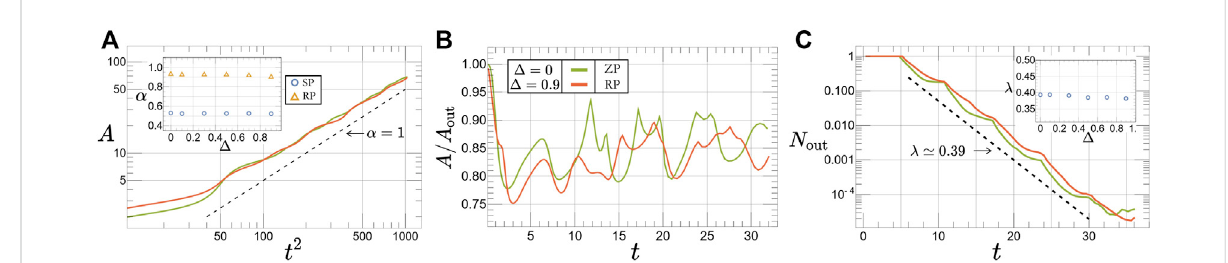
FIGURE 6 Long-time properties of the isochrones in curved space. (A) Area covered by the RP isochrone vs. t 2 on the oscillating surface with Δ = 0.9 (red curve). The green curve shows the corresponding ZP isochrone at Δ = 0. The inset shows the value of the exponent α de fi ned in the main text as a functionofthewaveamplitude Δ forbothSPandRP. (B) ComparisonbetweenthetimeevolutionofthefractionalareaforRPat Δ =0.9andZP.Both curvesoscillatearoundsimilarvalues ≈ .85. (C) Numberoftrajectories N out ontheouterisochroneforbothRPandZP[legendisthesameas( B )]. The inset shows the variation of the associated exponent with Δ . In all panels, the relative force strength is set to γ = 0.79 (con fi ning